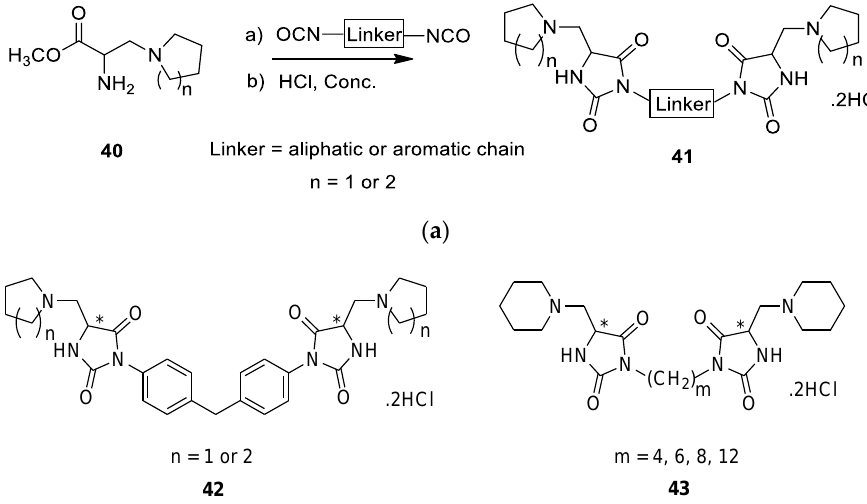
and 5.21 μM on U251 and KB3 -1 cell lines, respectively. This particular C2 -symmetric di- mer is connected by a biphenylmethane bridge. The IC 50 of cisplatin, the reference drug, was 3.06 and 6.90 μ M against these two cells, respectively. Generally, the hydantoin di- mers were more active in U251 cancer cells with an IC 50 ranging from 0.46 to 7.0 μ M in comparison with an IC 50 ranging from 5.21 to 26.08 μ M on the KB3-1 cells. Notably, amongst the dimers linked by a methylene chain, dimer 43 (m = 8) showed the best anti- proliferative activity on brain glioma cells (U251) with an IC 50 of 1.05 μ M. There was no clear relationship between the length of the aliphatic chain and the observed antiprolifer- ative activities.